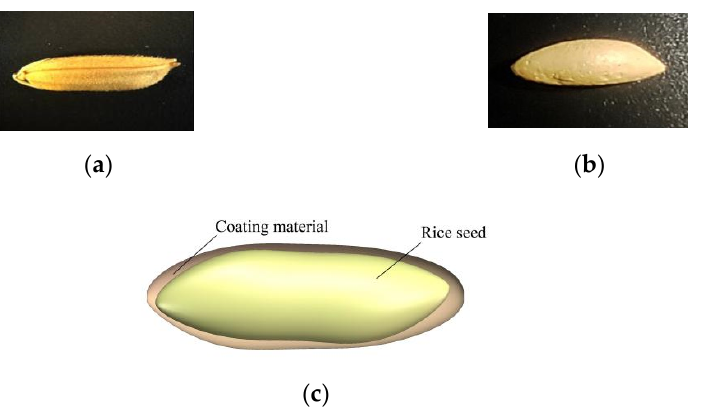
Figure 13. Coating treatment of rice seeds: ( a ) seed; ( b ) coated seed; ( c ) schematic diagram of coated seeds.